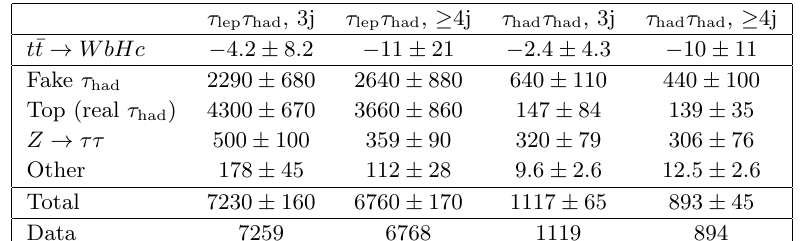
Table 8 . tqH ( (cid:28)(cid:28) ) search: predicted and observed yields in each of the analysis regions considered. The background prediction is shown after the (cid:12)t to data under the signal-plus-background hypothe- sis (assuming t (cid:22) t ! WbHc as signal). The contributions with real (cid:28) had candidates from t (cid:22) t , t (cid:22) tV , t (cid:22) tH , and single-top-quark backgrounds are combined into a single background source referred to as \Top (real (cid:28) had )", whereas the small contributions from Z ! ‘ + ‘ (cid:0) ( ‘ = e; (cid:22) ) and diboson backgrounds are combined into \Other". The quoted uncertainties are the sum in quadrature of statistical and systematic uncertainties of the yields, computed taking into account correlations among nuisance parameters and among processes.